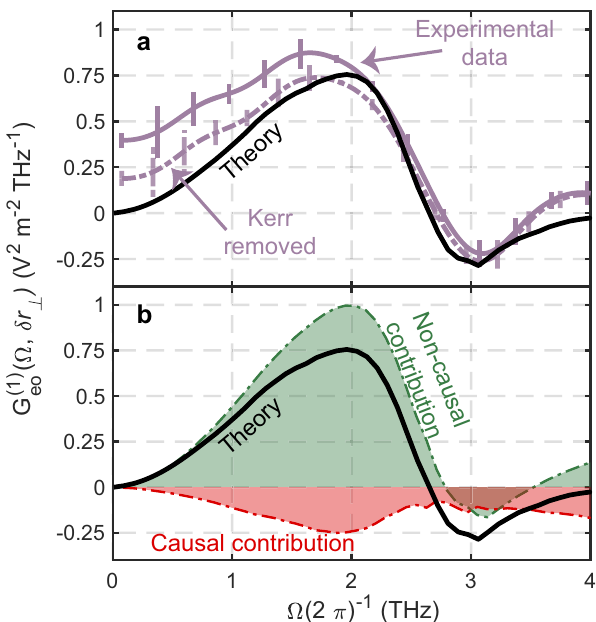
Fig. 3 Causal and noncausal electro-optic signal contributions. a The Fourier transform of the apodized measurement raw data shown in Fig. 2 (purple solid line) is compared to the theory (black solid line). Additionally, the experimental data with parasitic low-frequency contributions removed is shown by the dotted lines. The experimental error bars are also shown as vertical lines and they indicate the 2 σ statistical con fi dence interval. b The theoretical curve is separated in its causal (red dashed dotted line) and non-causal (green dashed dotted line)